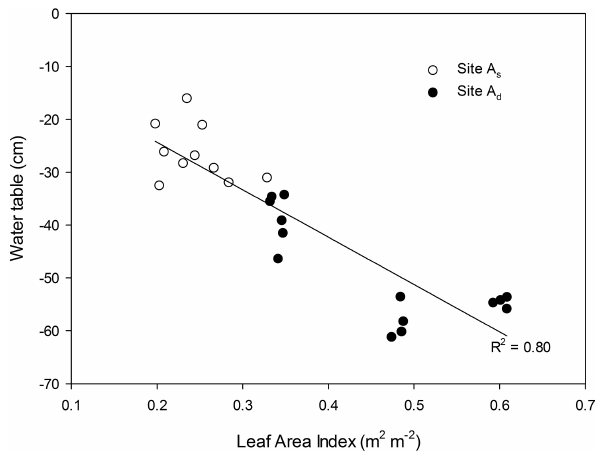
Figure 7. Vegetation mean growth rate (cmday − 1 ) at Sites A d and A s during periods between simulated grazing events (cuttings) dur- ing Year 1 and 2 (vertical bars denote ± one standard error; n = 7 for Site A d and n = 5 for Site A s ) . Means with the same letter are not significantly different ( p